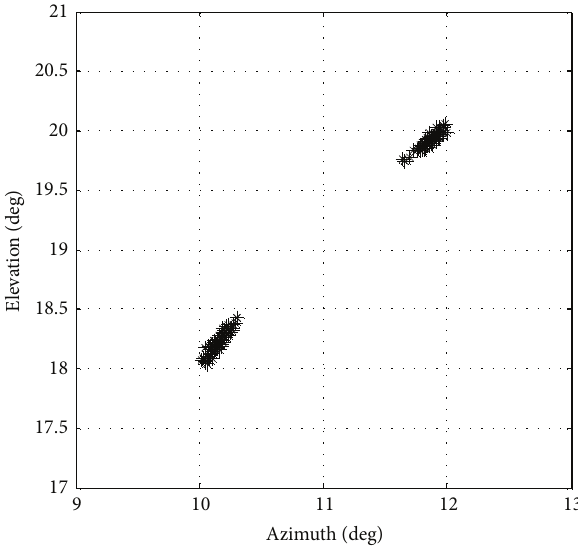
Figure 11: Angle estimation performance of the proposed algorithm with the closely spaced